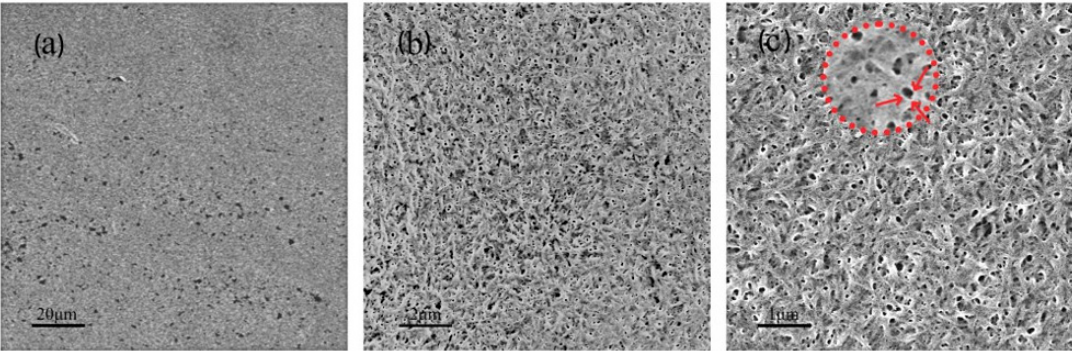
Figure 1. SEM of SiO 2 sensor before and after CNC adsorption.